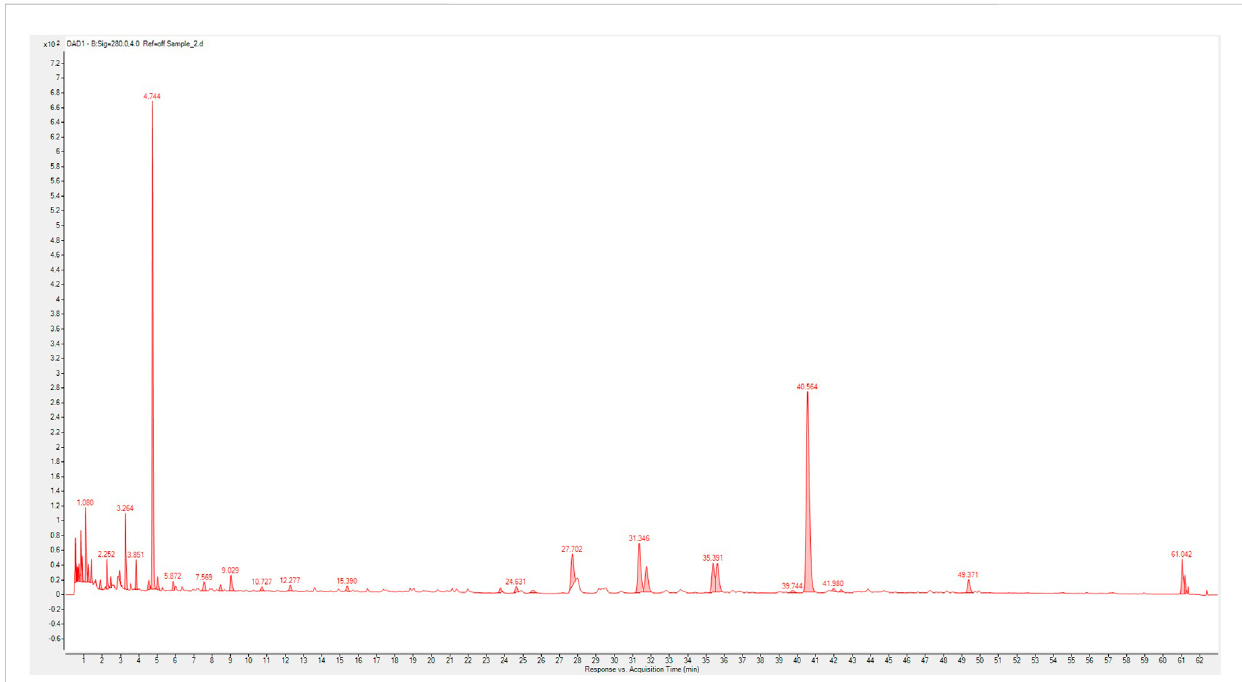
FIGURE 1 Composition fi ngerprintanalysis ofXSLZJTbyUP-HighPerformance LiquidChromatographytriple-quadrupolemassspectrometer. (1),hesperidin; (2), atractylenoide III; (3), glycyrrhizic